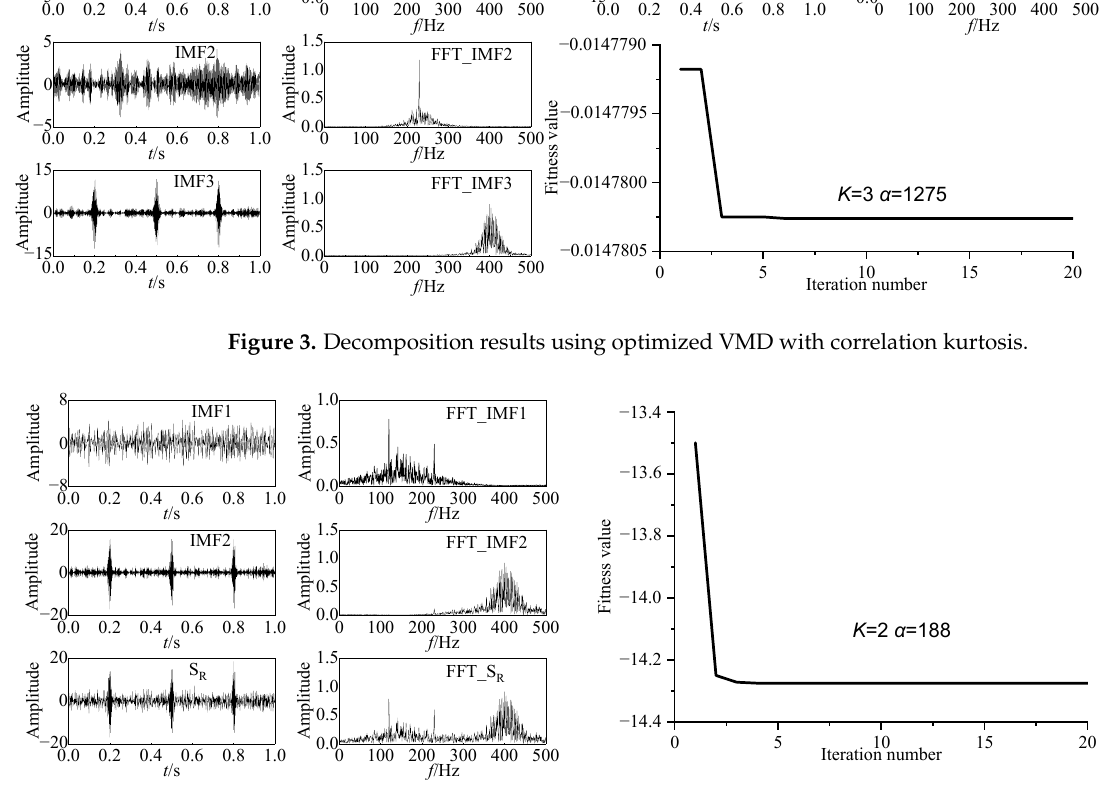
Figure 4. Decomposition results using optimized VMD with KCI .